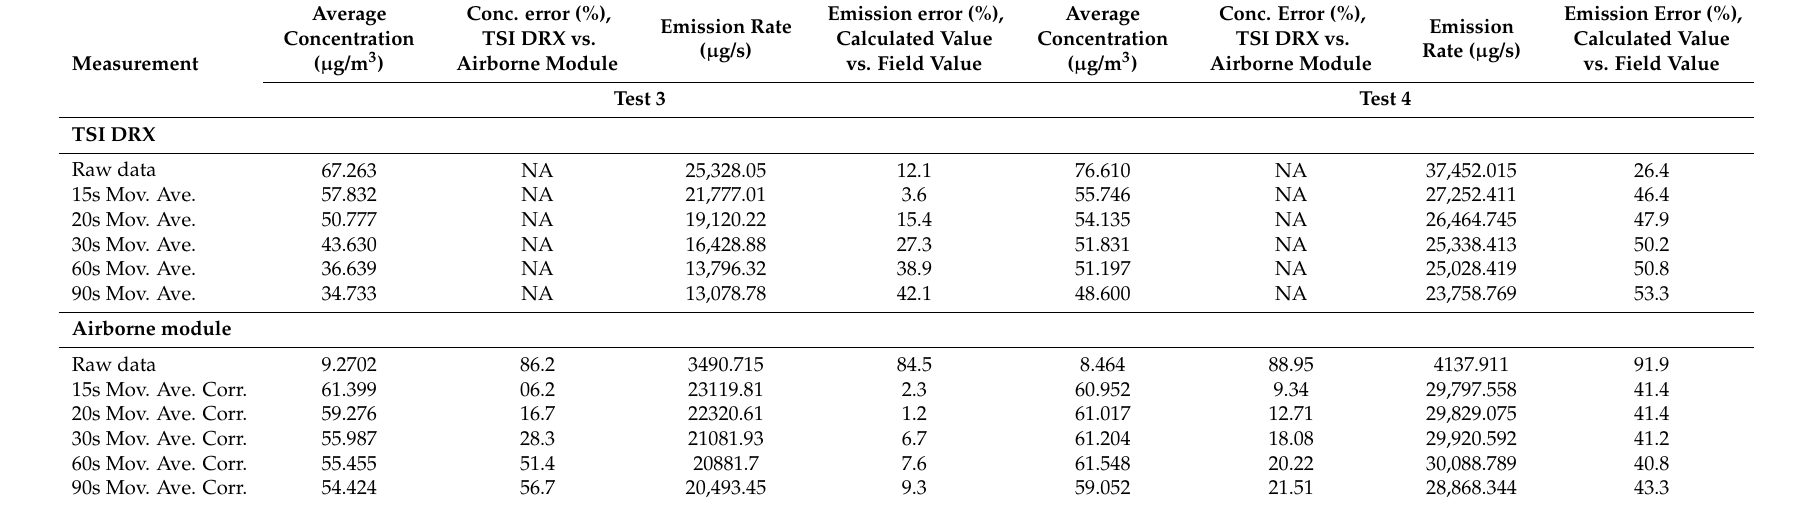
Table 9. Summary of concentrations and emission rates calculated for the triangle test with their percentage